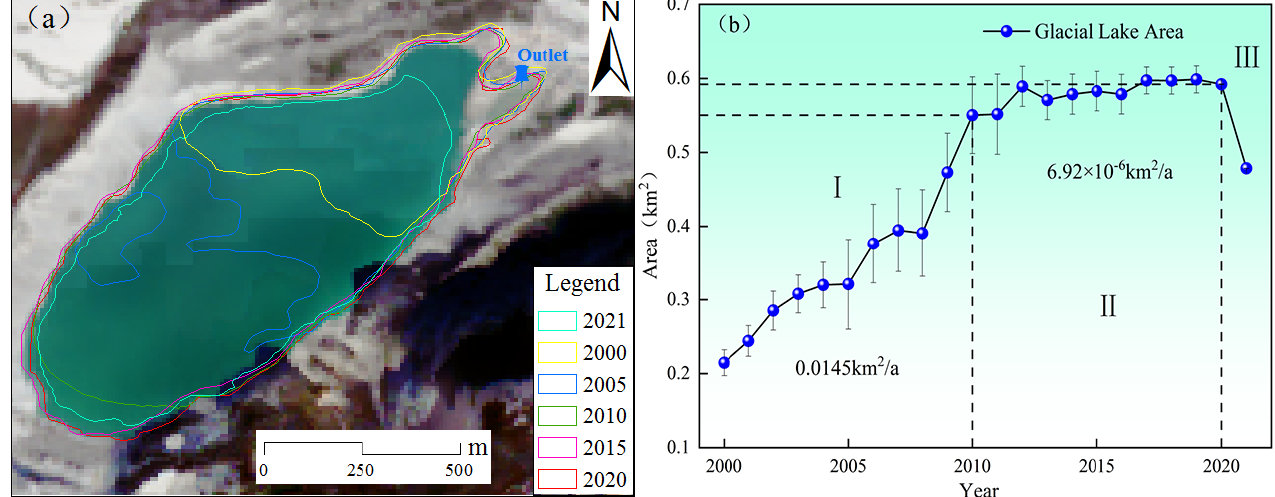
Figure 7. The change process of the area of Jialong Co glacial lake from 2000 to 2021. ( a ) The expansion of Jialong Co glacial lake from 2000 to 2021. ( b ) Interannual variation in the area of Jialong Co glacial lake from 2000 to 2021.